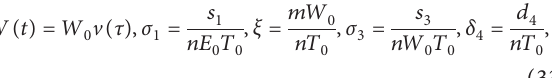
� 0 . 0001 and 0.0004, respectively. The stable state is represented by 2 ( 0 , 0 , z ,u ) , P ( 0 , y , z ,u ) , P ( 500 , 0 ,z , u ) , and 0 0 0 1 1 1 1 2 2 2 � 0 . 0001. (b) ω � 0 . from P , we move P up a little bit). (a) ω 0 1 1 2 2